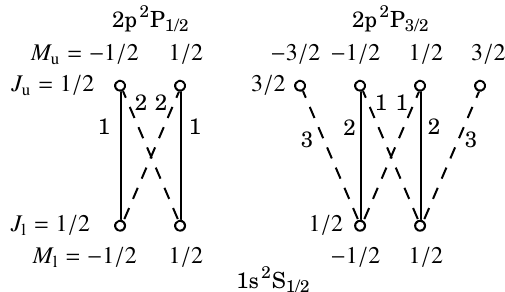
Figure 1. Kastler diagram for the Lyman- α line. The solid and dashed lines correspond to the ∆ M = 0 and ∆ M = ± 1 transitions, respectively. The numbers next to the lines indicate the relative line intensities when the population in the upper state is equally distributed over all the magnetic